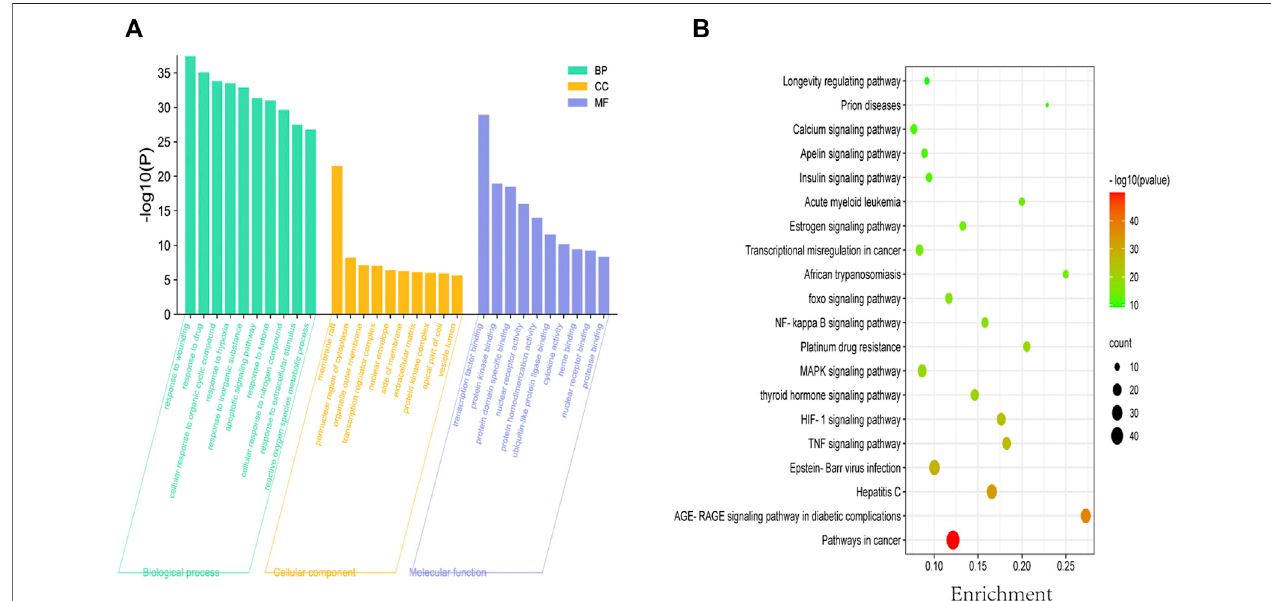
FIGURE 3 | Biofunctional enrichment analysis of Asparagus (ASP). (A) Top 10 biological processes, top 10 molecular functions and top 10 cellular components in the GO analysis. (B) Top 20 KEGG pathways. The color scale indicates the different thresholds of p values and the size of the dots represents the number of genes corresponding to each